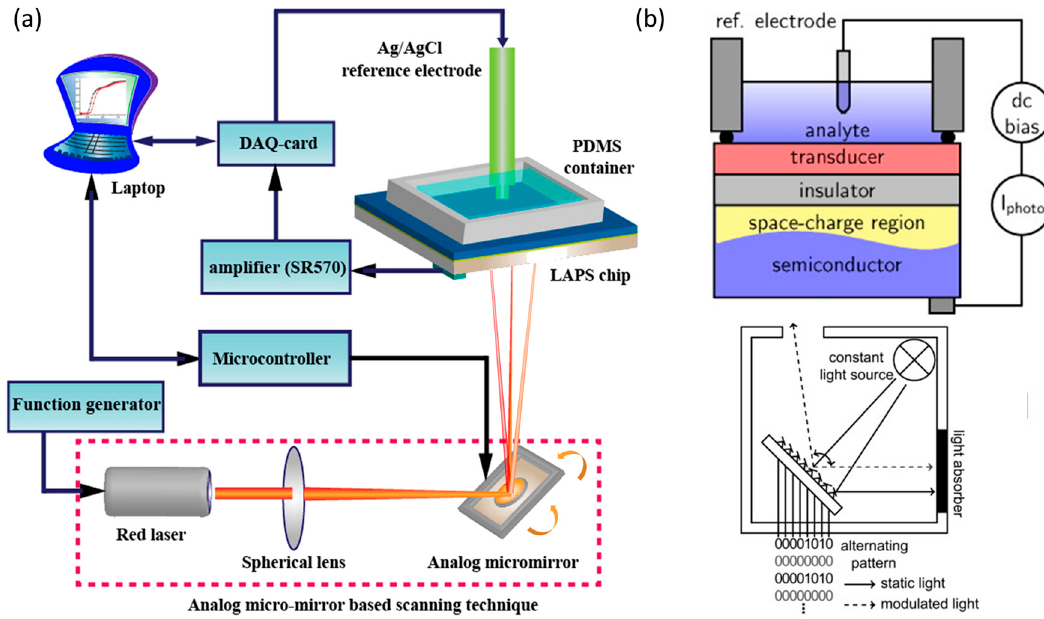
Figure 6. ( a ) Schematic of the LAPS imaging system based on analog micromirror. Reprinted from; ( b ) Schematic of the LAPS imaging system based on the DLP, the light is modulated by the fast switching mirrors and the position and size of the light spot can be adjusted as required. Reprinted (adapted) with permission from Das et al. [124] and Wagner et al. [125] Copyright (2019) Elsevier.